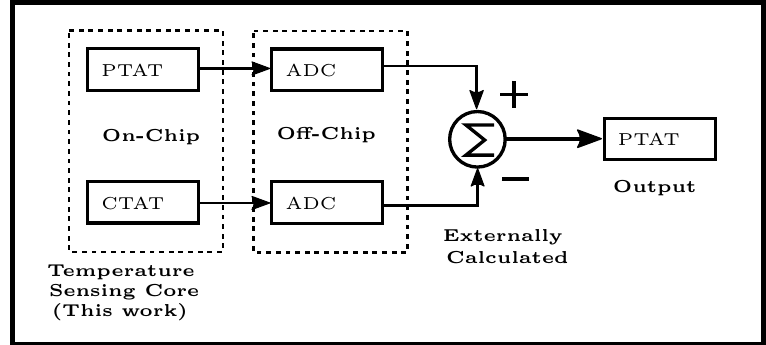
Figure 1. Conceptual block diagram of proposed temperature